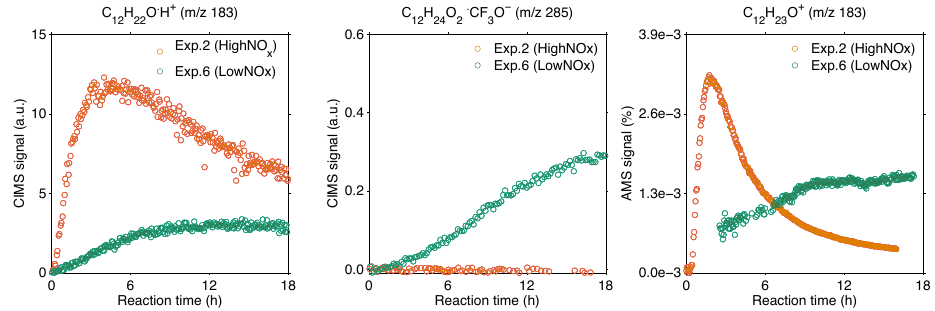
Figure 4. Temporal profiles of ion C H O ⋅ H + ( m/z = 183) and C H O CF O - ( m/z = Fig. 4. Temporal profiles of ion C 12 H 22 O · H + ( m/z = 183) and C 12 H 24 O 2 · CF 3 O − ( m/z = 285) measured by CIMS and ion C 12 H 23 O + 12 22 12 24 2 ⋅ 3 ( m/z = 183) measured by AMS under high- and low-NO x conditions. Details of experimental conditions are given in Table 1. 285) measured by CIMS and ion C H O + ( m/z = 183) measured by AMS under high- 12 23 and low-NO conditions. Details of experimental conditions are given in Table 1. organonitrate-substituted dihydrofuran, and (3) H-atom ab- 4.2 Formation of cyclic hemiacetals and x straction from a C atom with the –ONO 2 functional group at- alkyl-substituted dihydrofuran tached and further H-atom abstraction from a C atom poten- tially leads to a carbonyl-substituted dihydrofuran. It is worth CIMS measurement at (+) m/z 183 in positive mode repre- noting that the gas-phase ozonolysis of alkyl-substituted di- sents the ion C 12 H 22 O · H + generated from the proton trans- hydrofuran under high-NO x conditions contributes to most fer reaction with alkyl-substituted dihydrofuran ( M w = 182). of the ozonolysis reactions because the alkyl-substituted di- An additional source of (+) m/z 183 is the proton trans- hydrofuran is a major first-generation product, as shown in fer reaction followed by dehydration of hydroxyl dode- Fig. 3b (H). canone ( M w = 200), which is also detected as a fluoride